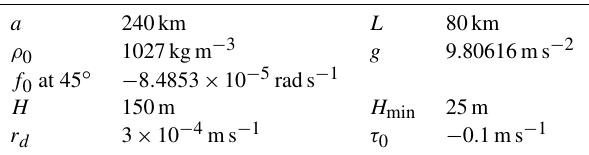
Table 2. Parameters for the upwelling test case: reference density ρ 0 , Coriolis parameter f 0 , gravitational acceleration g , wind stress τ 0 , bottom friction r d , planetary radius a , minimum depth H min , maximum depth H , channel meridional width L